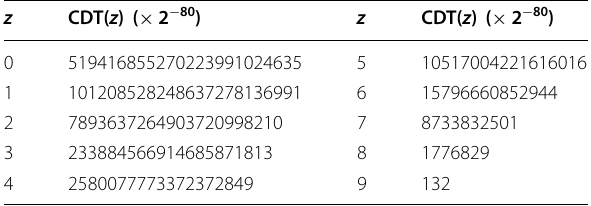
Table 5 The approximate CDT of D N ,1 with 80-bit